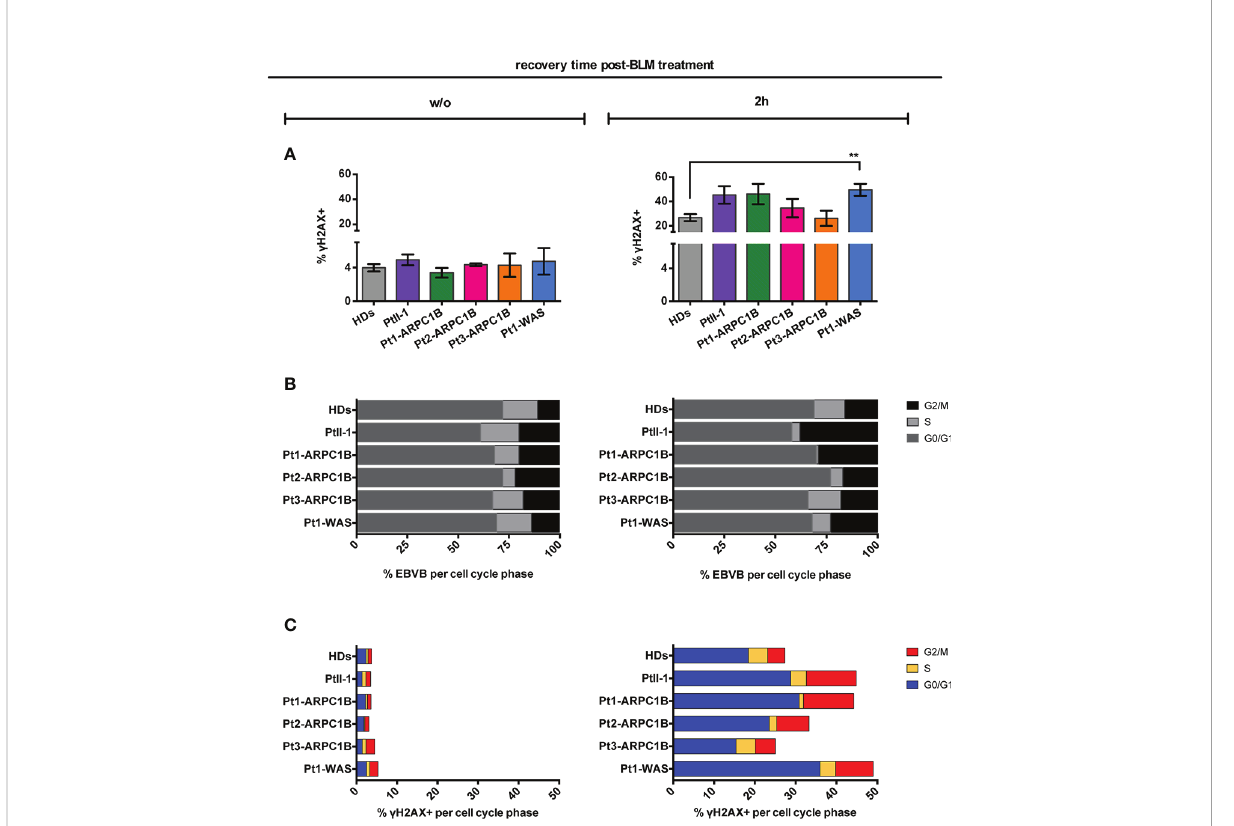
FIGURE 2 Radiosensitivity evaluation in ARPC1B-de fi cient cells after 2 h of bleomycin treatment. (A) FACS analysis of g H2AX expression in EBVB cells from HDs, Pt-II1, Pt1-3 ARPC1B, and Pt-WAS with or w/o BLM treatment (9 µM/1 h). Column bar graphs show the mean ± SEM ( n > 3; HDs = 15). (B) Distribution of cells into the cell cycle phases before and after 2 h of BLM treatment (FACS). Each bar represents the mean of cells determined in at least three independent experiments. (C) Quanti fi cation of the g H2AX + EBVB cells in each cell cycle phase (FACS). The percentage of cells in G0/ G1, S, and G2/M cell cycle phases ( g H2AX + with respect to singlet cells) was represented as mean ± SEM ( n > 3). Statistical signi fi cance was calculated with one-way ANOVA and Bonferroni ’ s posttest: ** p <